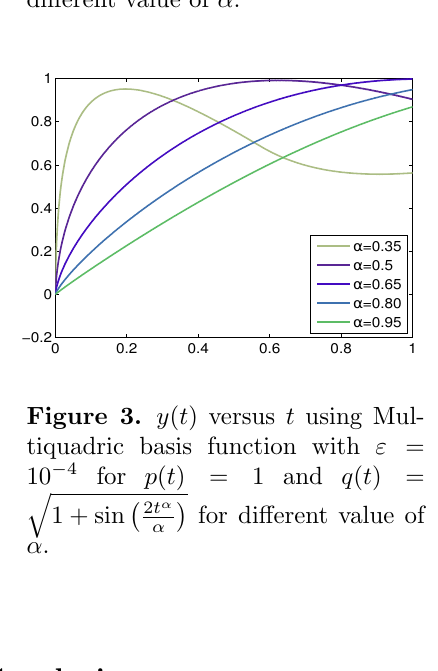
Figure 2. y ( t ) versus t using multi- quadric basis function with ε = 10 − 4 for p ( t ) = α and q ( t ) = 1 + t α for different value of α .